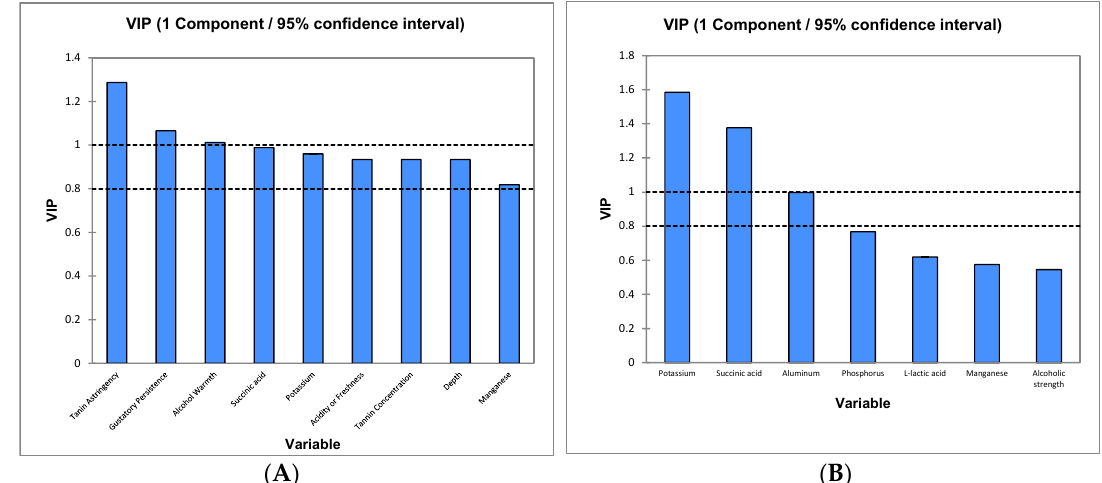
Figure 7. ( A ): Variable Importance in Projection (VIP) graphic of the models proposed for the gustatory “minerality” descriptor in red wines constructed on the chemical profile of active gustatory compounds. ( B ): Idem based on the values of the descriptive sensory analysis from the data extracted from the six red wines in the study.